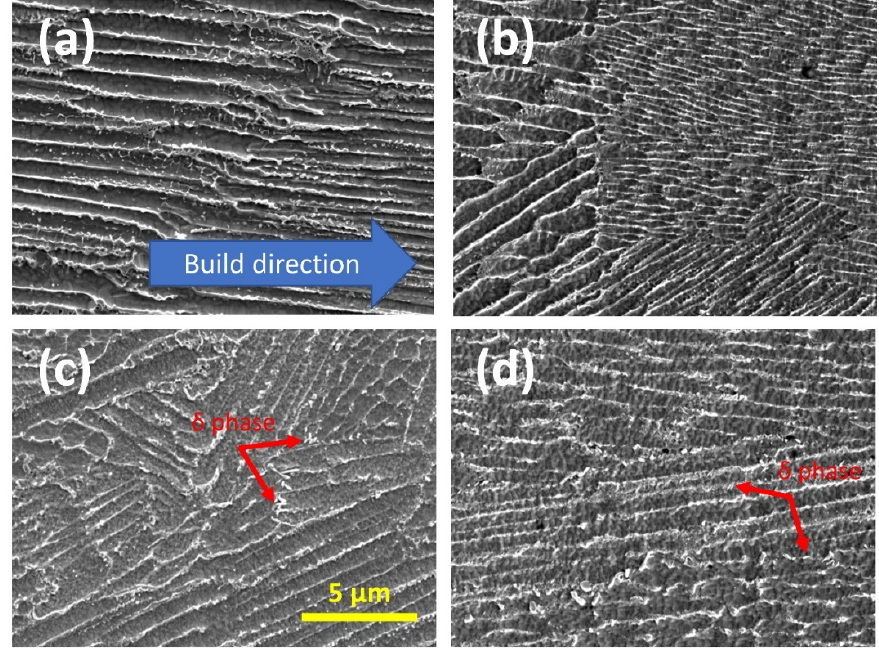
Figure 2. Microstructure in AM IN625 under four different conditions ( a ) as-fabricated, ( b ) after a one-hour heat treatment at 700 °C, ( c ) after a 24 h heat treatment at 700 °C, and ( d ) after a one-hour heat treatment at 800 °C. The imaged surfaces are all parallel to the build direction. Red arrows in ( c , d ) highlight the platelet δ phase precipitates.